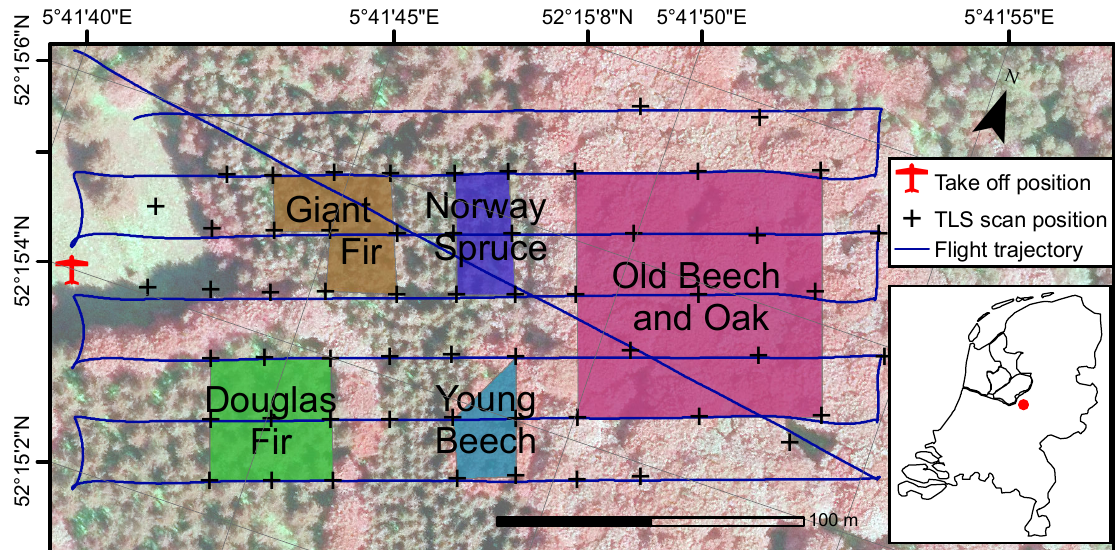
Figure 2. Map of the study site with TLS scan positions (crosses), take off position (red plane), flight lines (blue), target areas, study site location in the Netherlands (red dot in inset), airborne false colour composite as background